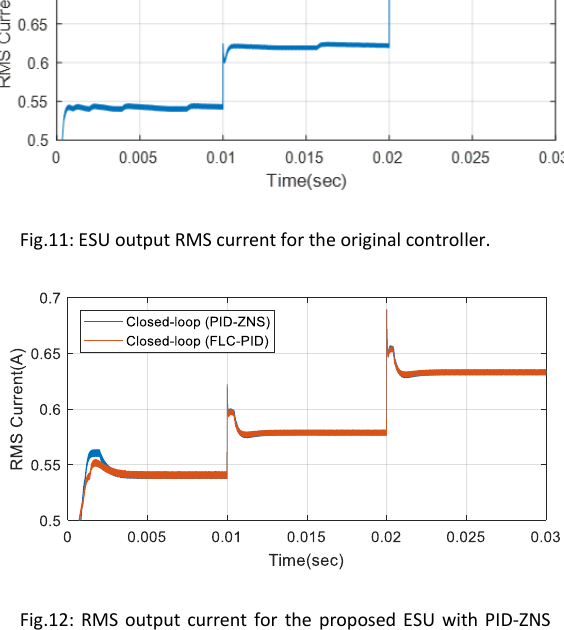
Fig.12: RMS output current for the proposed ESU with PID-ZNS and FLC-PID controller.